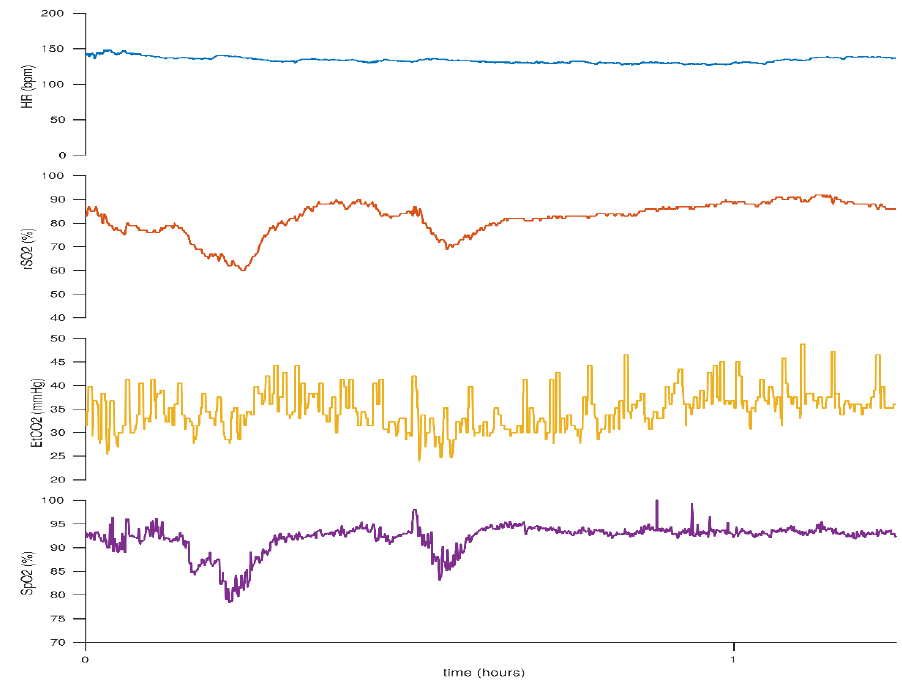
Figure 7. Cerebral rSO 2 and peripheral SpO 2 are decreased by reducing administered FiO 2 . This figure reflects the case of a neonate born at 25 + 2 weeks gestation. BW 530 g, DOL 1.